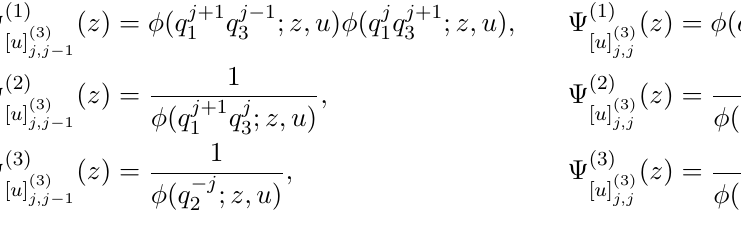
q − 1 u ) . Top: 1 3 , after acting E ( z ) several times, the action on the j,j,j − 1 s ( z ) ⊗ E ( z )[ u ] [ q − 1 q − 1 u ] j,j,j − 1 = 0 . Middle: 1 1 j,j,j − 1 ⊗ 1 3 , after acting E ( z ) several times, the action on the j,j − 1 ,j − 1 s ( z ) ⊗ E ( z )[ u ] [ q − 1 q − 1 u ] j − 1 ,j − 1 ,j − 1 = 0 . 3 3 j,j − 1 ,j − 1 ⊗ 1 3 , after acting E ( z ) several times, the action on j,j,j s ( z ) ⊗ E ( z )[ u ] [ q − 1 q − 1 u ] j,j,j = 0 . 3 3 j,j,j ⊗ 1 3